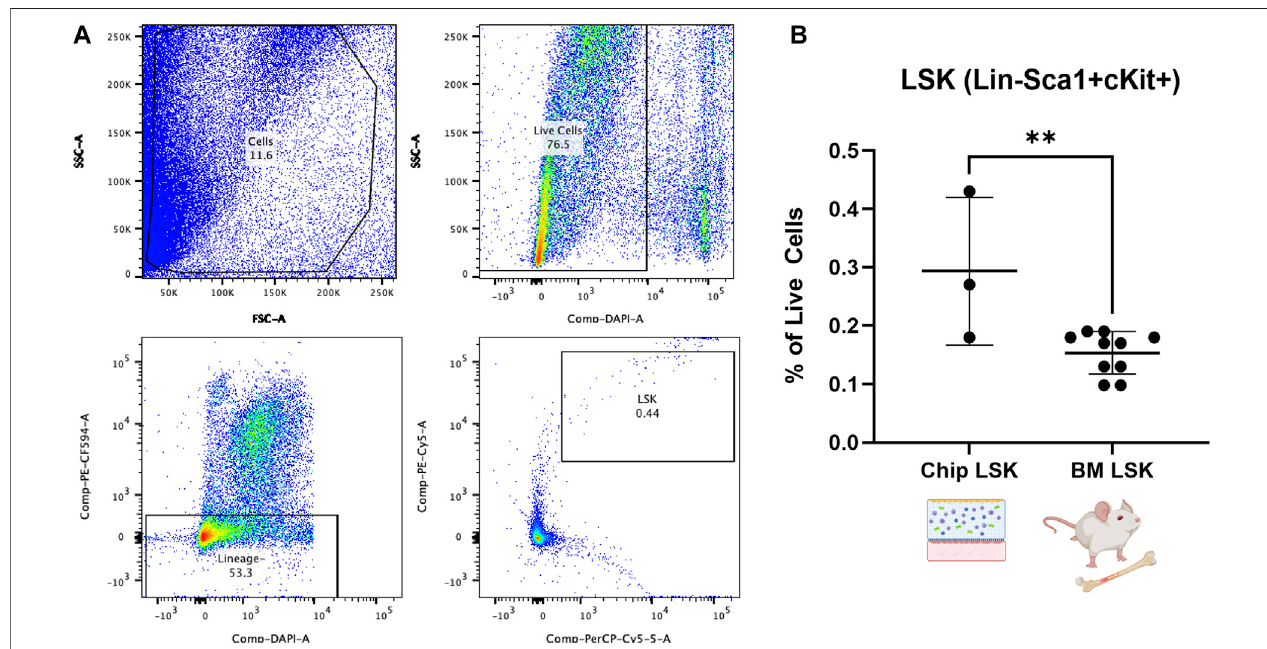
FIGURE3| FlowcytometricanalysisofHSPCcells(LSK:Lineage-,Sca1+,cKit+)fromwholebonemarrowcellsinBMME-on-Chip. (A) Gatingstrategyforanalysis ofLSKcellsusingFlowJov10. (B) PercentofLSKinlivecellspopulationinthechiponD21andcontrolC57Bl/6JBMat6 – 8 weeksofage(Mean,SD).Statisticalanalysis was performed using an unpaired t -test. **: p ≤ 0.01. BM: Bone